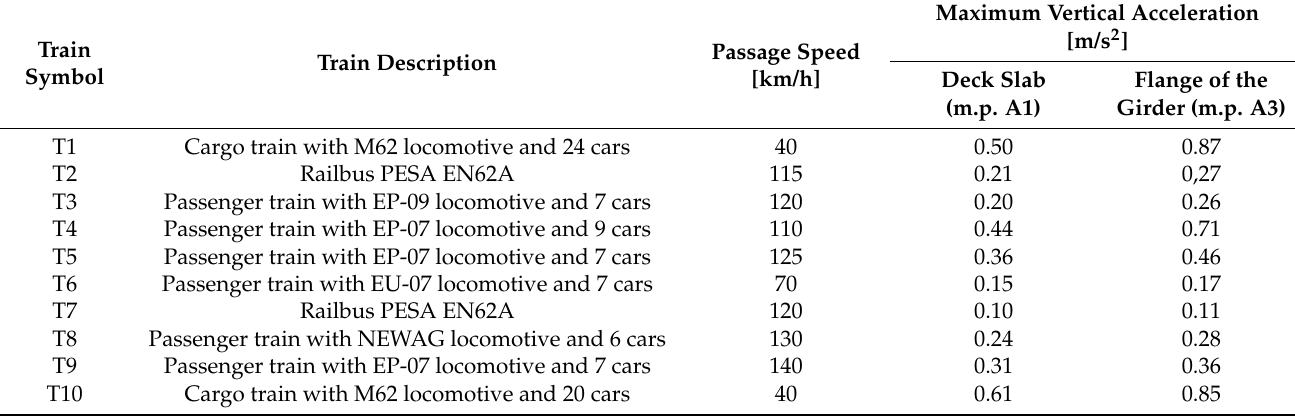
Table 1. Results of vibration acceleration